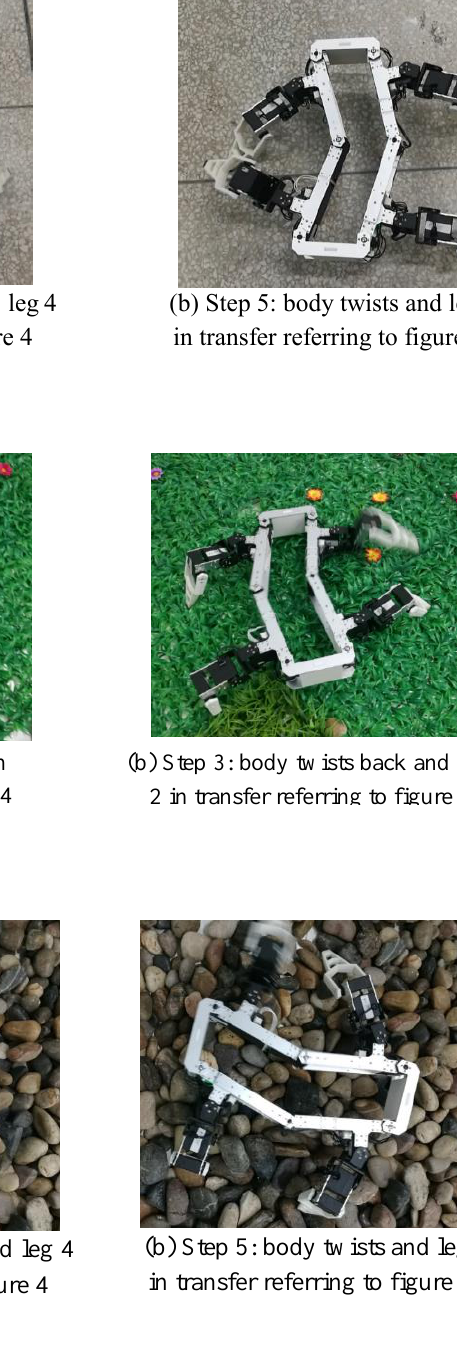
Figure 20. The MetaRobot I walking on